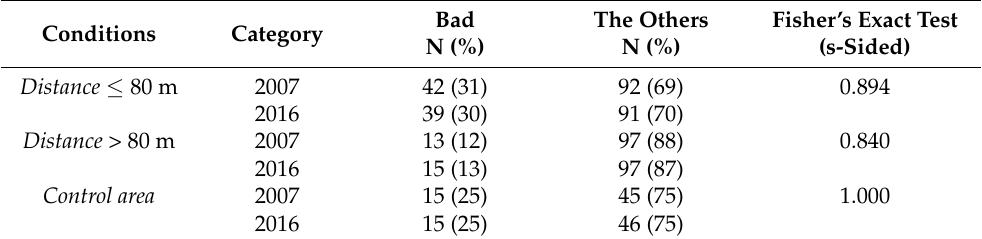
Table 10. Cross-tabulation and Fisher’s exact test for the quietness.